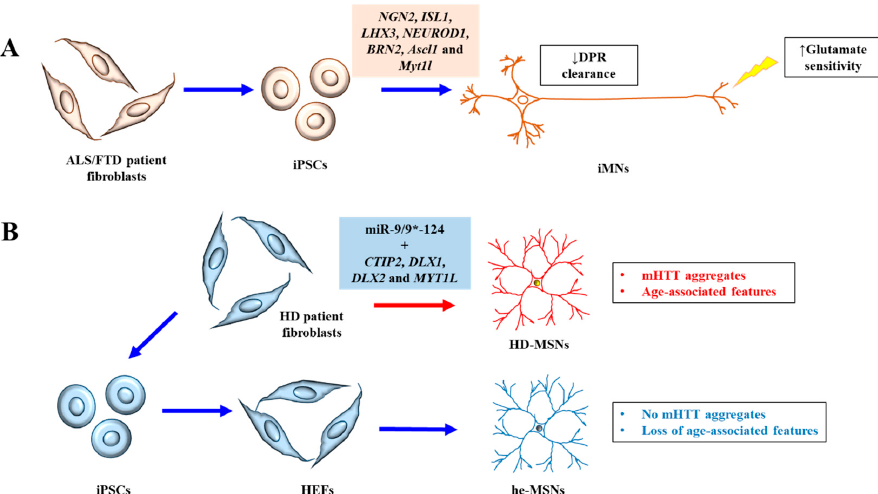
Figure 1. A schematic diagram illustrating the recent advances discussed. ( A ) Induced motor neurons (iMNs) generated from ALS/FTD patient iPSCs exhibiting increased sensitivity to glutamate and decreased clearance of dipeptide repeat (DPR) proteins. ( B ) Striatal medium spiny neurons directly induced from HD patient fibroblasts (HD-MSNs) exhibited clear HD neuronal phenotypes of mutant Huntingtin (mHTT) aggregates and age-associated features like DNA damage and oxidative stress, which is not seen in MSNs derived from human embryonic fibroblasts (HEFs) generated from patient-derived iPSCs (he-MSNs).